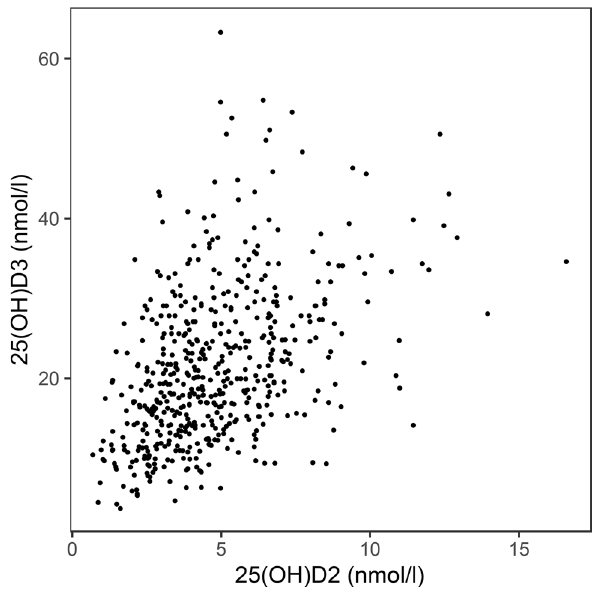
Figure 2. Scatterplot showing the relationship between 25(OH)D2 and 25(OH)D.